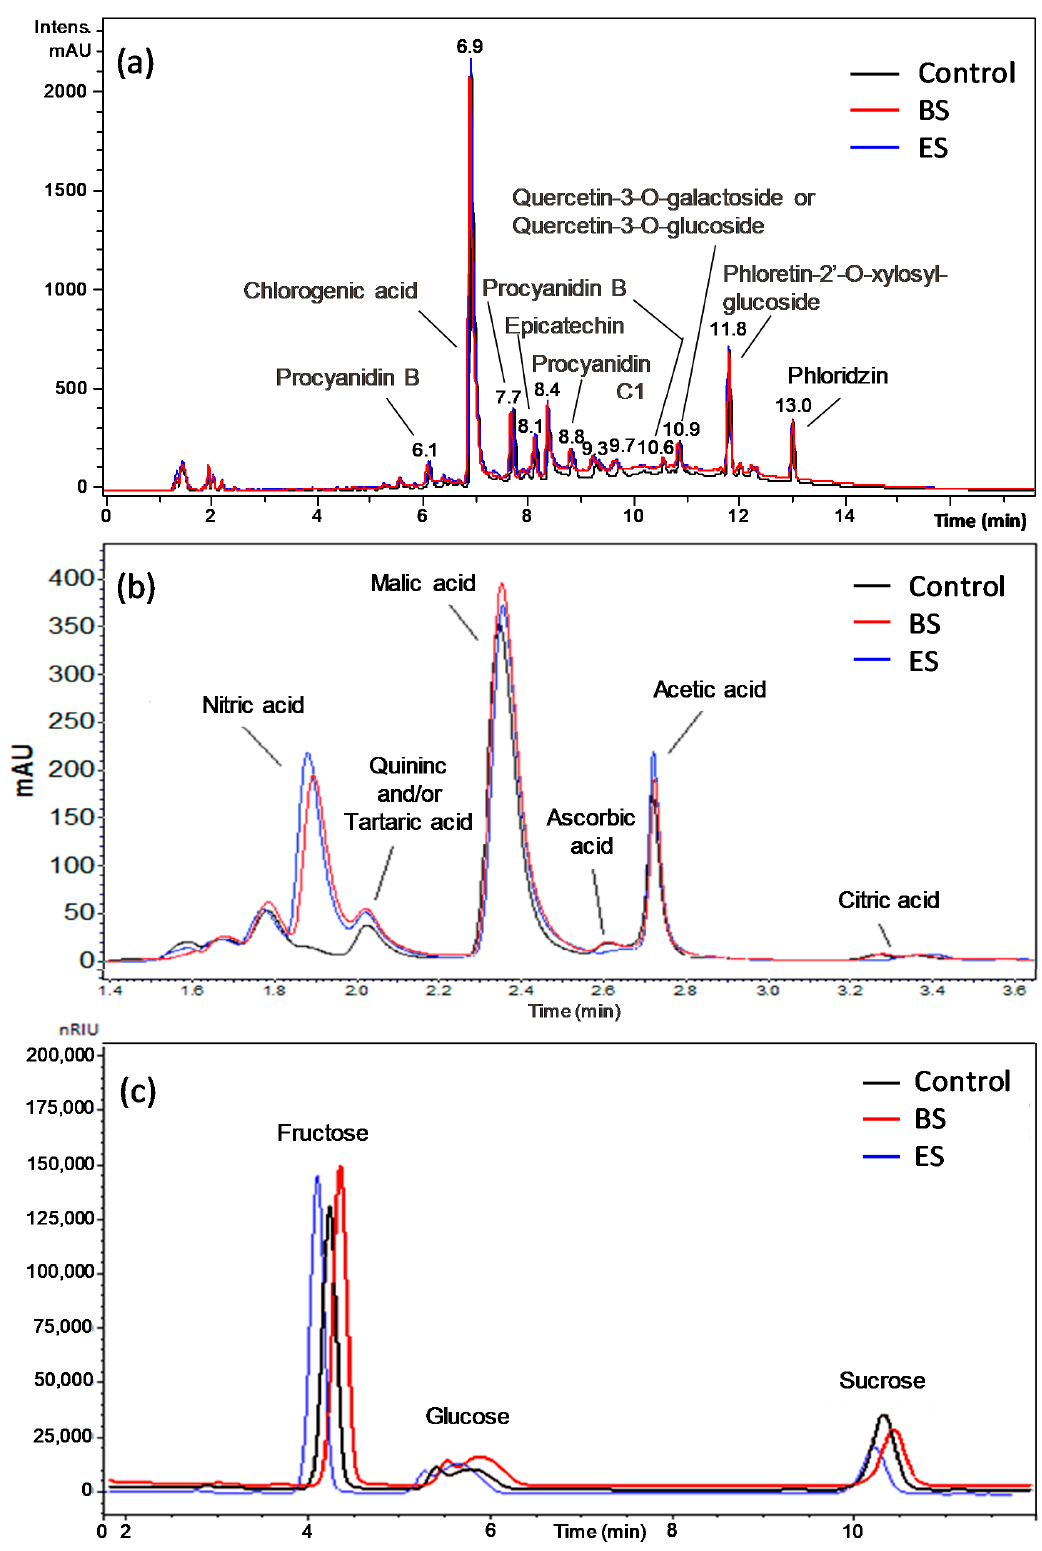
Figure 5. HPLC analyses of the untreated (control), batch system (BS)-treated, and electrospray system (ES)-treated apple juice samples using instrumental conditions to detect ( a ) polyphenols, ( b ) organic acids, and ( c ) sugars (see the Material and Methods, Section 2.5 for details).